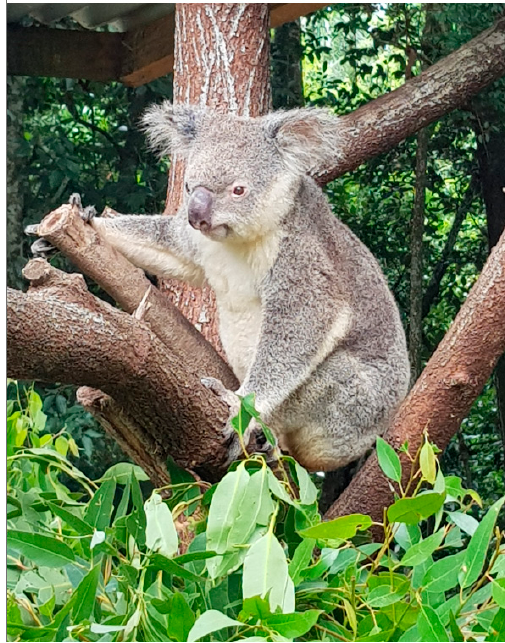
Figure 1. Koala ( Phascolarctos cinereus ). Photo credit Bonnie Quigley.